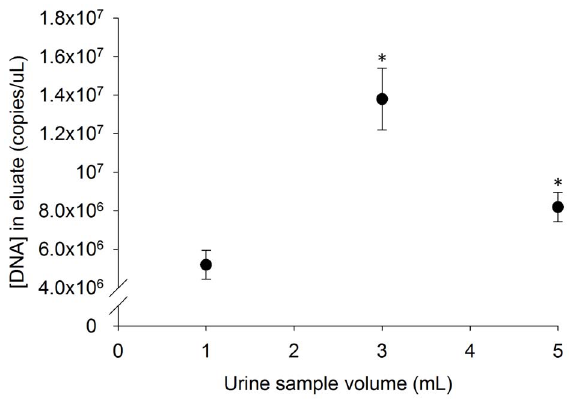
Figure 3. The final concentration of IS6110 DNA in the eluate following magnetic bead-based extraction of 3 and 5 mL spiked urine samples is significantly higher than the IS6110 DNA concentration in the eluate following the extraction of 1 mL samples (mean 6 s.d., n=3); * denotes statistically different from 1 mL sample.